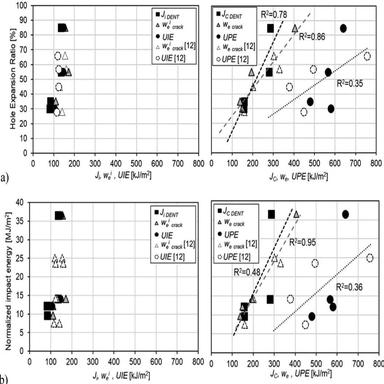
Correlation between fracture toughness and: (a) edge cracking resistance, expressed as the hole expansion ratio ; (b) crashworthiness, in terms of normalized axial impact energy . The fracture toughness parameters investigated in this work (solid symbols) are plotted together other published toughness values (open symbols) . Left: Crack initiation resistance. Right: Crack propagation resistance (correlation coefficient is indicated).